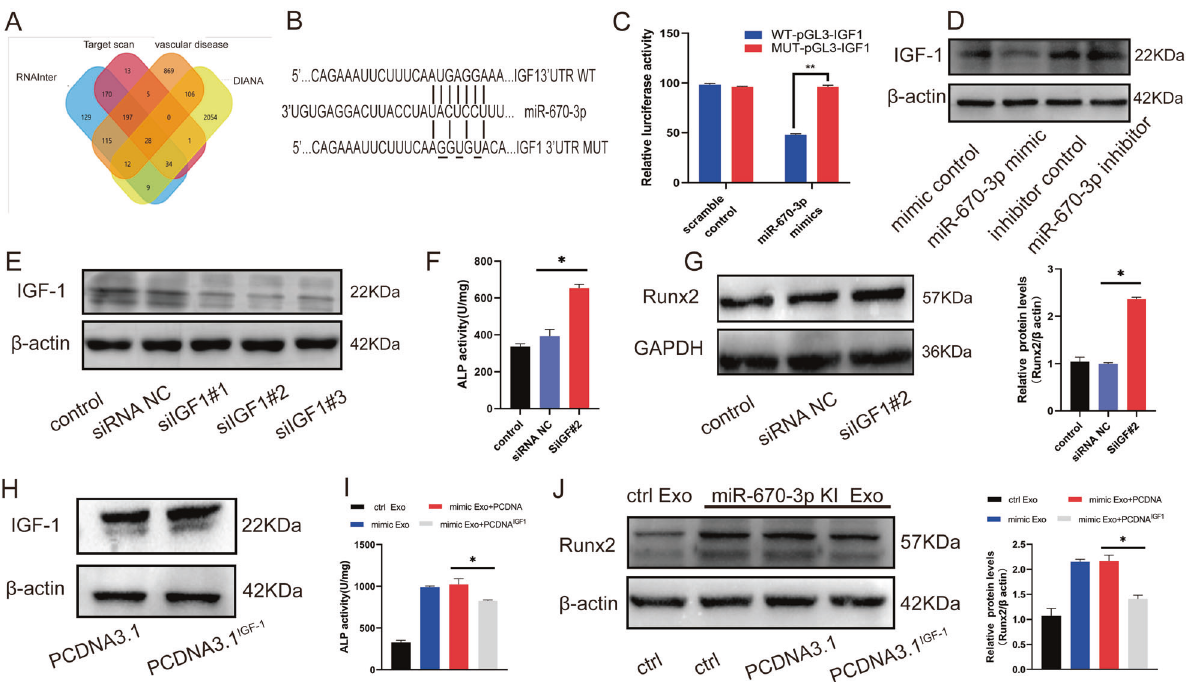
Fig. 4 IGF-1 was the direct target gene of miR-670-3p and regulated VSMCs calci fi cation. A Venn diagram of the predicted target gene of miR-670-3p from Target scan (red), RNAInter (blue), DIANA (yellow), and vascular calci fi cation disease (orange). Three genes were identi fi ed as miR-670-3p target genes. B Schematic representation of miR-670-3p putative target sites in IGF-1 3 ′ -UTR and alignment of miR-670-3p with WT and MUT IGF-1 3 ′ -UTR showing pairing. C Luciferase reporter assays were performed using luciferase constructs carrying a wild type or mutant IGF-1 3 ′ -UTR co-transfected into VSMCs with miR-670-3p mimics compared with empty vector control. Fire fl y luciferase activity was normalized to renilla luciferase activity. D The expression level of IGF-1 protein in VSMCs transfected with miR-670-3p mimics or miR-670-3p inhibitor was indicated by western blot. E The ef fi ciency of IGF-1 knockdown in VSMCs by siRNA was measured by western blot. F ALP activity was measured in the VSMCs treated with siIGF #2 or siRNA control. G Runx2 expression was measured in the VSMCs treated with siIGF #2